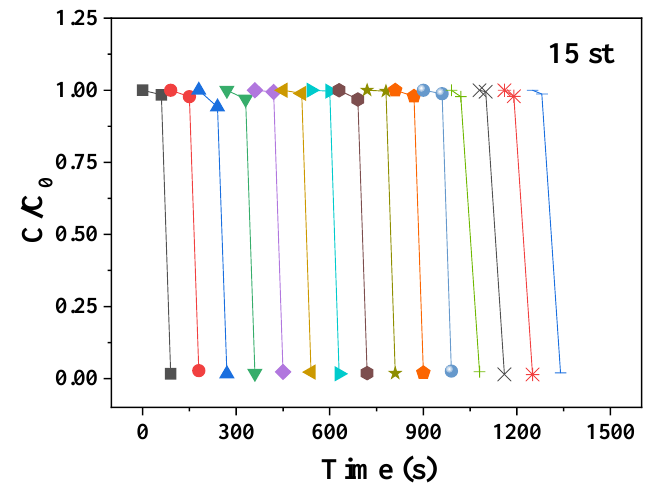
Figure 8. Photocatalytic degradation curves of different dyes ( a ) MO. ( b ) MB. ( c ) CR. And ( d ) Dye degradation rate curve.